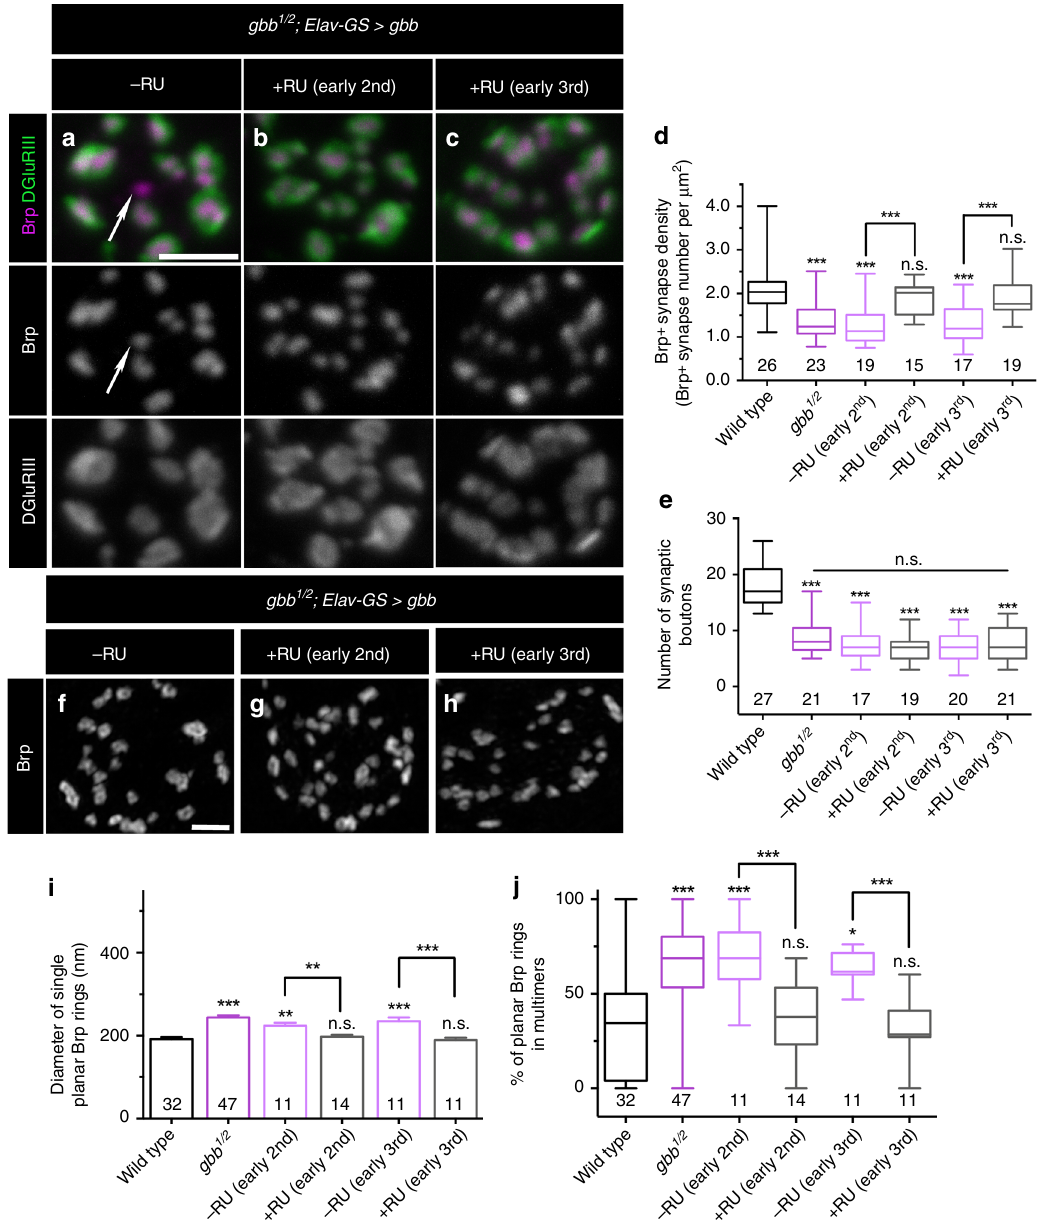
Fig. 5 An ongoing requirement for presynaptic BMP signaling. a – c Representative z -projections of boutons labeled with labeled with Brp (magenta) and DGluRIII (green) of gbb 1/2 mutants with transgenic UAS-gbb under the control of ElavGeneSwitch . Arrows denote unapposed Brp + puncta. Scale bar: 2 µ m. d Quanti fi cation of Brp + synapse density. n is the number of boutons. e Quanti fi cation of the number of boutons. n is the number of NMJs scored. f – h Representative z -projections of boutons of the indicated genotypes and treatments labeled with anti-Brp. Scale bar: 1 µ m. i Quanti fi cation of single planar Brp ring diameters. j Quanti fi cation of the percentage of planar Brp rings in multimers. For Brp ring analyses, n is the number of boutons scored. For the bar graph, error bars are mean ± SEM. For all box-and-whisker plots, error bars are min and max data points, and the center line indicates the median. n.s. not signi fi cantly different. * p < 0.05; ** p < 0.01; *** p < 0.001. All tests are nonparametric Kruskal – Wallis one-way ANOVAs on ranks followed by Dunn ’ s multiple comparison We fi nd approximately 40 Brp-positive puncta at NMJ 6/7 in used in our larval analysis did not permit us to map the cellular wild type (Fig. 6a, f). Unexpectedly, while Brp-positive puncta requirement of Gbb in embryos. As an alternative we assayed number is unchanged in gbb or wit null embryos (Fig. 6a – c, f), crimpy mutants. Crimpy is a neuronal Gbb-binding protein that the gross morphology of these NMJs is abnormal. Whereas traf fi cs presynaptic Gbb to dense core vesicles (DCVs) for wild-type embryonic NMJs are characterized by clusters of activity-dependent release 24 . Loss of Crimpy impairs embryo- nic bouton formation (Fig. 6d, g), raising the surprising pos- well-de fi ned boutons, NMJs in gbb and wit mutants are elon- sibility that while NMJ expansion depends on postsynaptic gated with fewer and smaller boutons. Speci fi cally, we fi nd a Gbb, initial bouton formation may be regulated by the pre- 50% reduction in bouton number in gbb and wit mutants synaptic ligand pool. (Fig. 6a – c, g). The motor neuron and muscle-speci fi c drivers